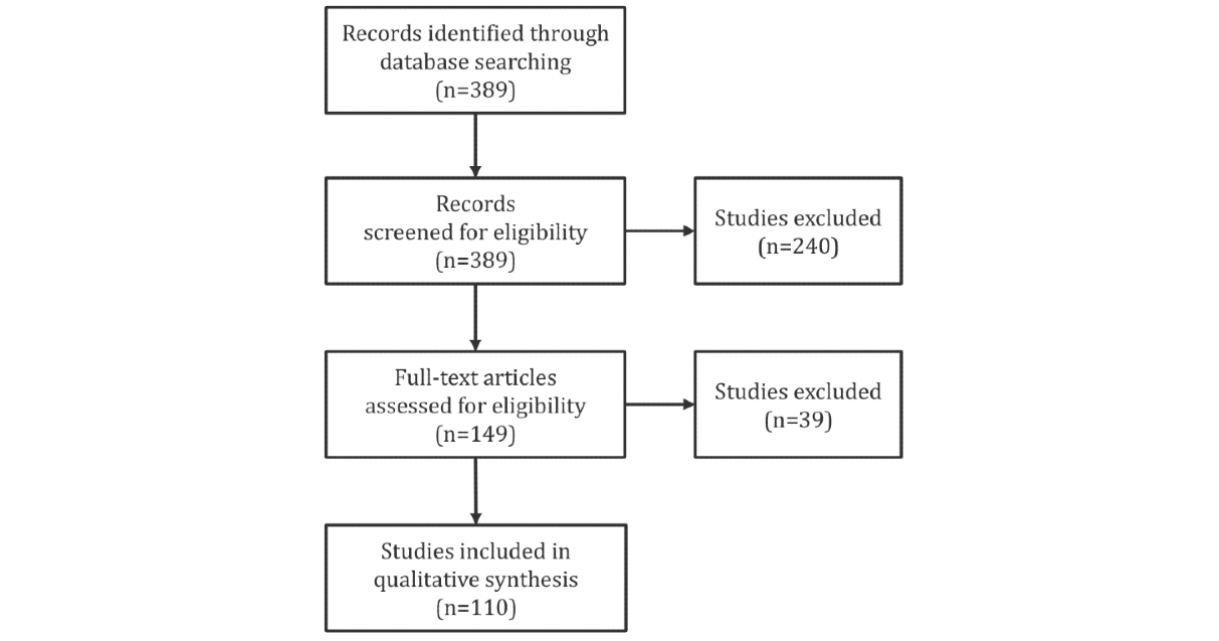
Figure 1. Flow diagram of the literature review